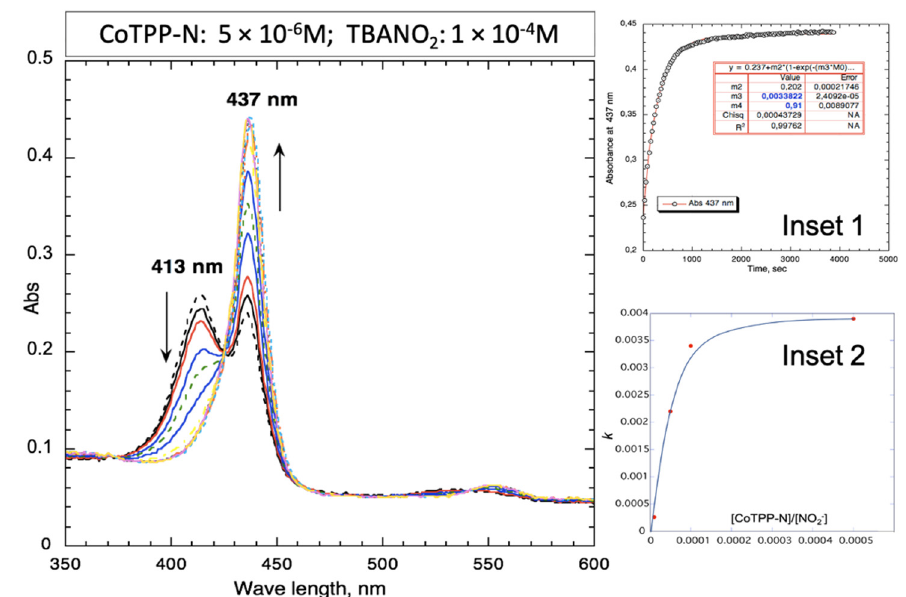
Figure 2. The evolution of UV-vis spectra of CoTPP-N (5 × 10 − 6 M) in ACN, upon the aggregation in the presence of 1 × 10 − 4 M TBANO 2 . Uppermost trace: t = 0, lowermost trace: t = 1.5 h. Inset 1: corresponding kinetic profile at wavelength of 437 nm. Inset 2: variation of the aggregation rate ( k app) with [CoTPP-N]/[NO 2 − ] ratio.